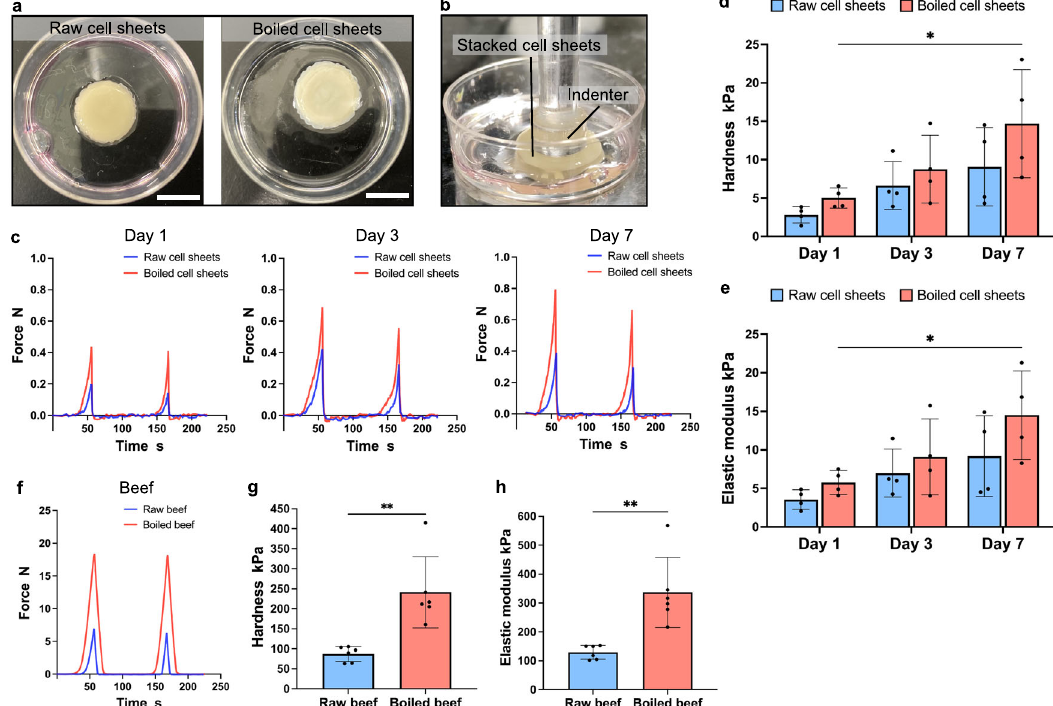
Fig. 4 TPA of the stacked cell sheets and beef. a Left: raw cell sheet tissue. Right: boiled cell sheet tissue. Scale bar: 1 cm. b Image of the indenter pressing the stacked cell sheet. c TPA curves, ( d ) hardness, and ( e ) Elastic modulus of raw and boiled stacked cell sheets ( n = 4). f TPA curves, ( g ) hardness, and ( h ) Elastic modulus of raw and boiled beef ( n = 6). In ( d , e ), the error bars represent SD, and the data points represent individual values. * P < 0.05 was considered signi fi cant in the analysis between groups using two-way ANOVA, with Tukey ’ s HSD. In ( g ) and ( h ), the error bars represent SD, and the data points represent individual values. ** P < 0.01 was considered signi fi cant in the analysis between paired t